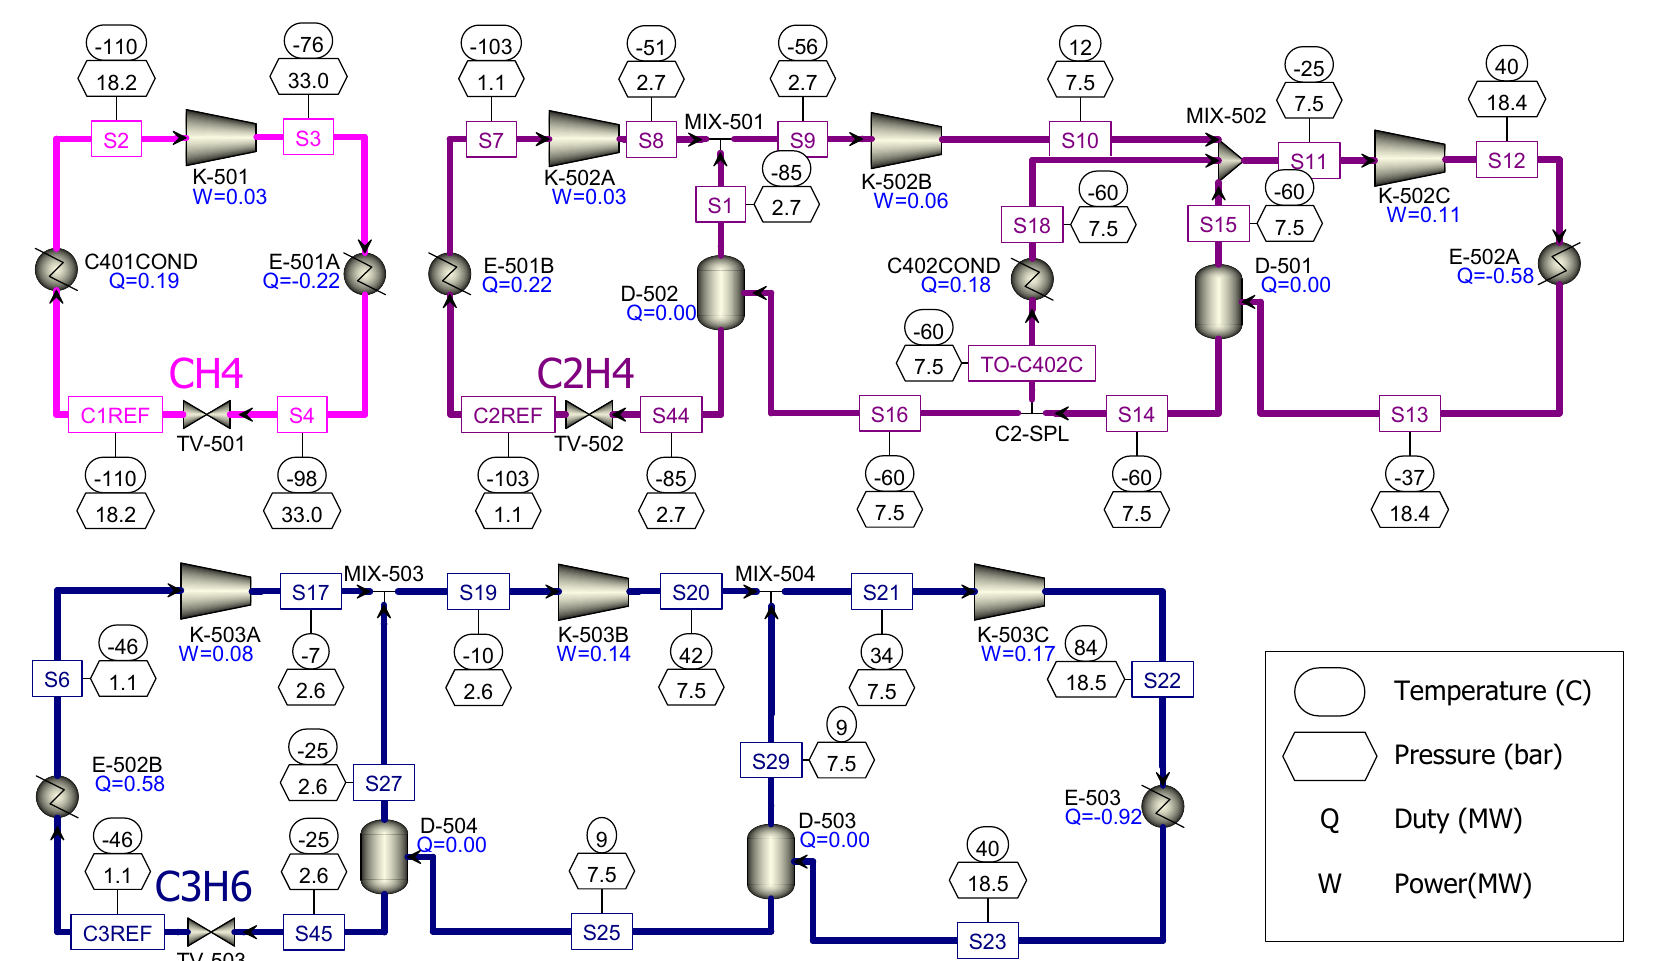
Figure 10. Process simulation of the external refrigeration system of the traditional distillation configuration implemented in Aspen Plus software. Reproduced with permission from Penteado, Ph.D. Thesis, TUB, 2021